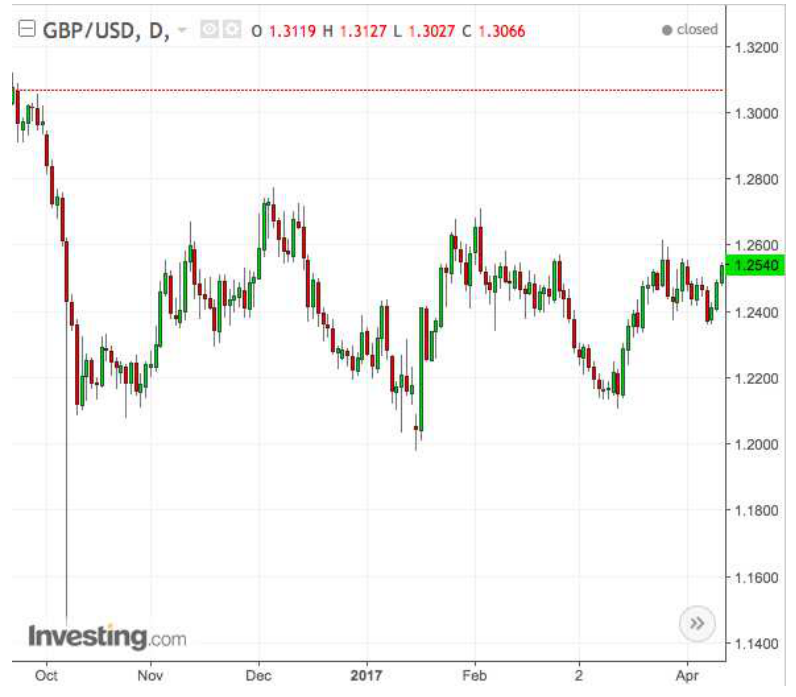
Figure 7. Dynamics of the GBP/USD pair from October 2016 to April